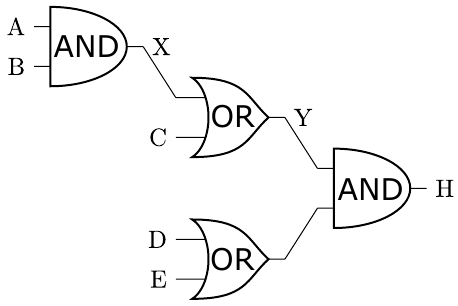
Figure 8. A classical inferential circuit with AND and OR